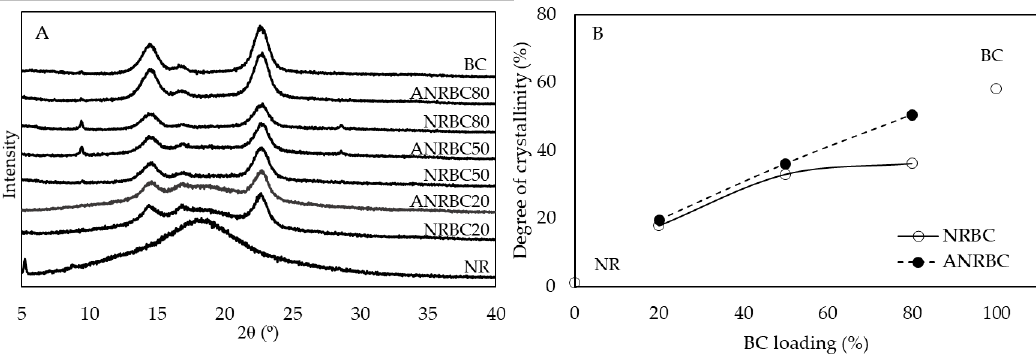
Figure 5. XRD pattern ( A ) and degree of crystallinity ( B ) of NR, BC, NRBC, and ANRBC composites.